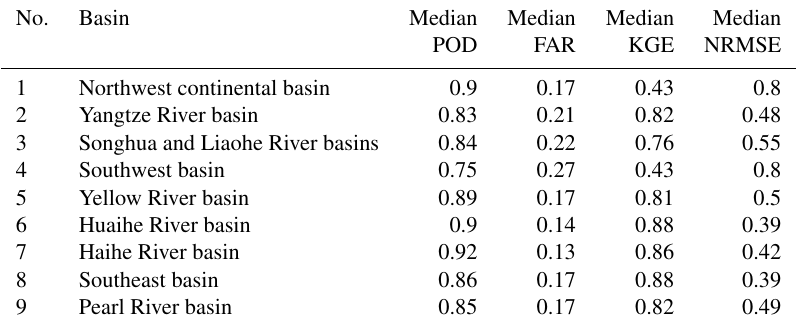
Table 5. Validation of the reconstructed precipitation in nine major basins of China. The benchmark dataset is the CMPA. POD: probability of detection, FAR: false alarm rate, KGE: Kling–Gupta efficiency, NRMSE: normalized root mean squared error. In northern (latitude > 40 ◦ N) and western (40 ◦ N > latitude > 27 ◦ N and longitude < 100 ◦ E) China, only data in May–September are used for